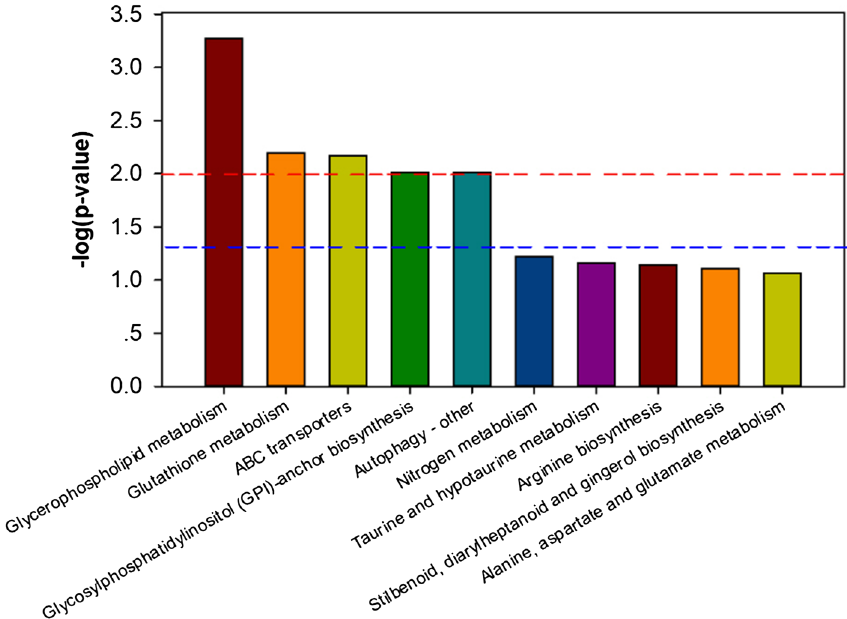
Figure 5. KEGG enrichment of the differential metabolic pathways.